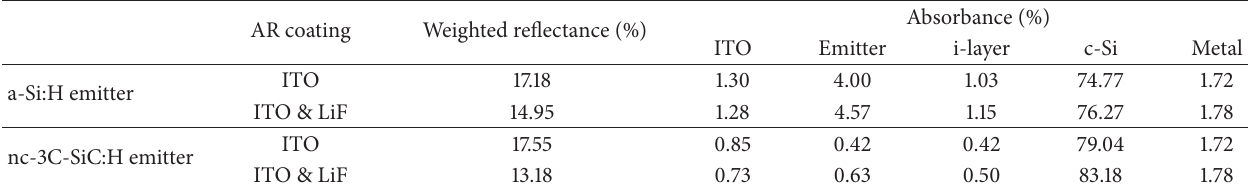
Table 1: Comparative result of the total reflectance and the total absorbance in each layer with different AR coating schemes and emitter layer for flat SHJ solar cell. The thicknesses of AR and emitter are optimized values. Absorbance (%) AR coating Weighted reflectance (%) ITO Emitter i-layer c-Si